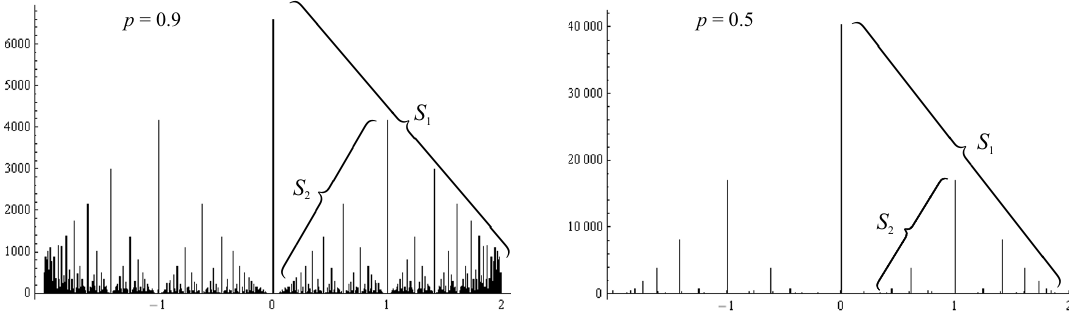
Figure 2 . The spectral density ρ ( λ ) for the ensemble of three-diagonal random operators of size N = 200 at p = 0 . 9 (a) and p = 0 . 5